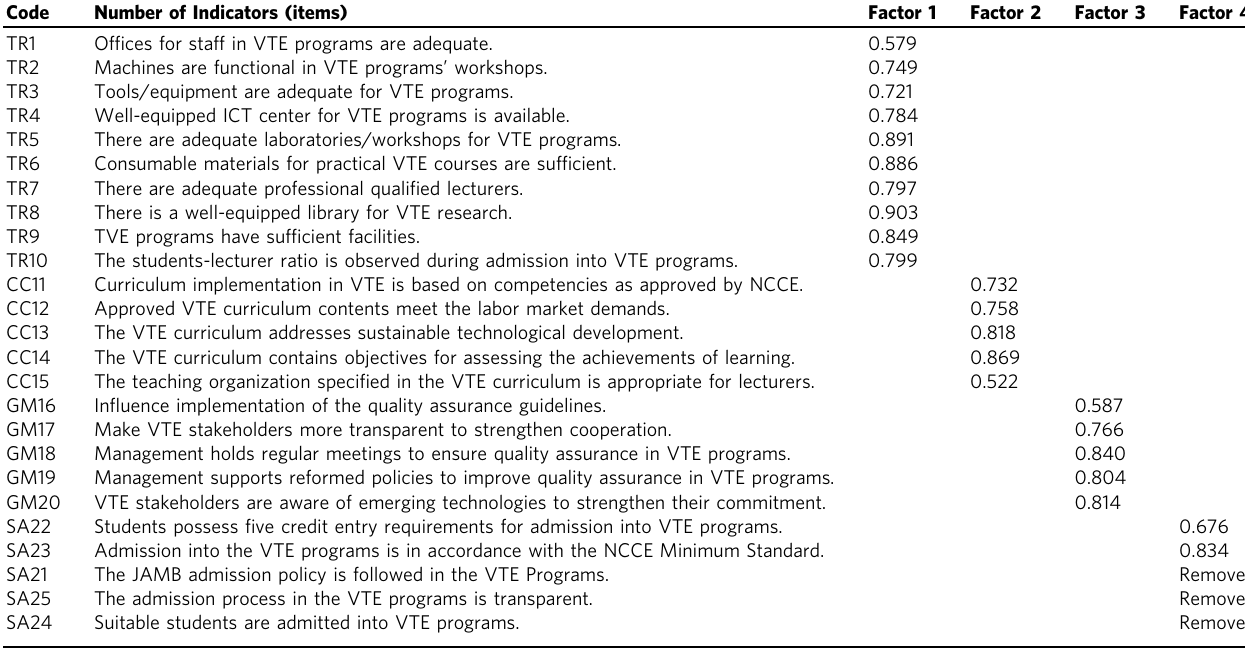
Table 4 Rotated component matrix of input QA factor structures and loadings.